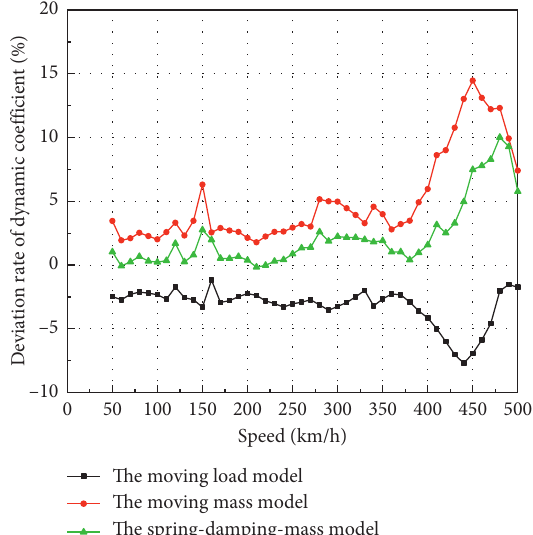
Figure 12: Deviation rate of the dynamic coefficient of the bridge midspan under different models.